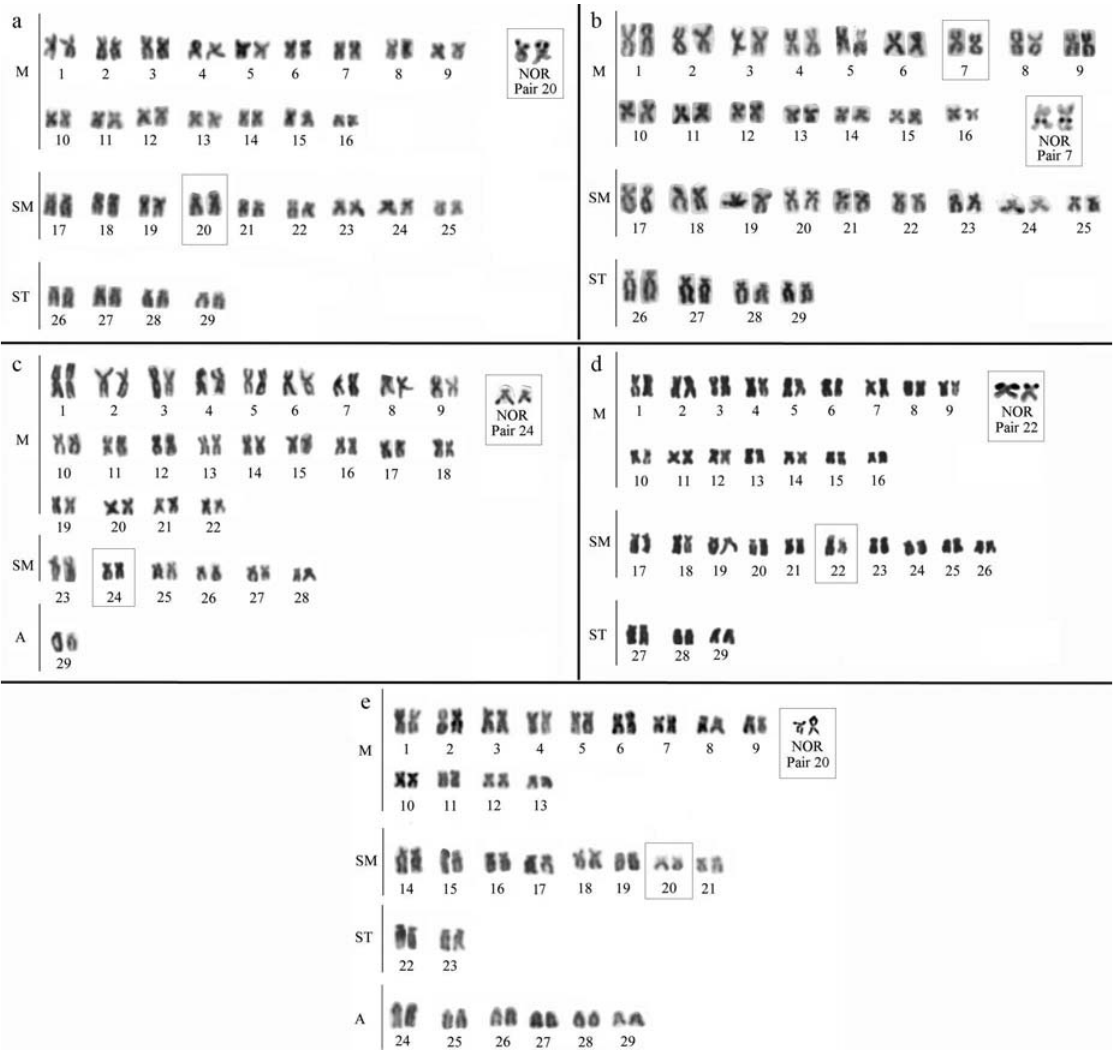
Figure 1 - Giemsa stained karyotypes of the species: a) Hassar cf. orestis ; b) Hassar sp.; c) Opsodoras ternetzi ; d) Hassar orestis ; e) Platydoras cf. costatus . Within the boxes are the NOR-stained chromosomes of each